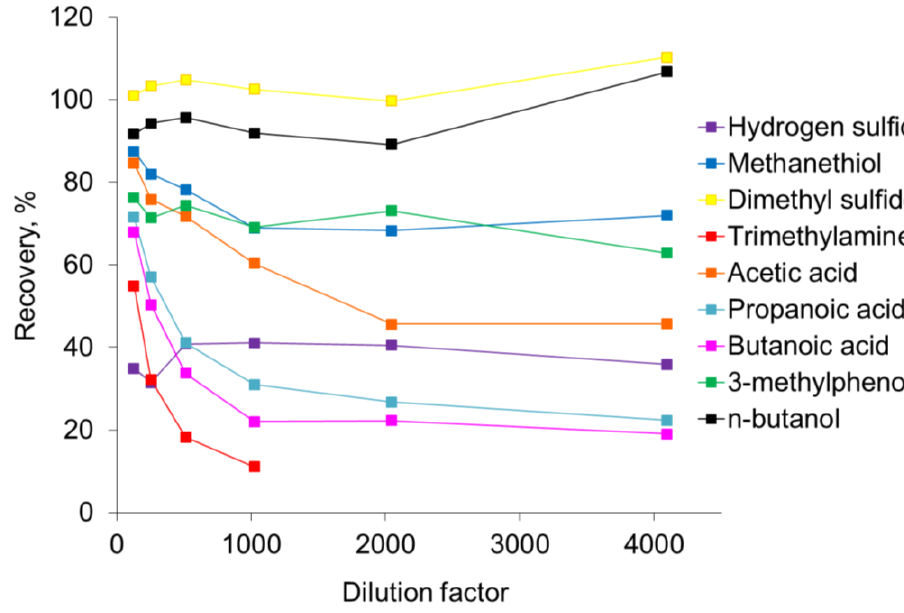
Figure 2. Recovery of odorants in the outlet tubing of an olfactometer as a function of the dilution